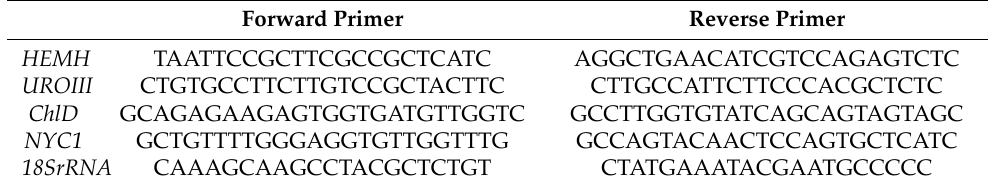
Table 1. Primers for qRT